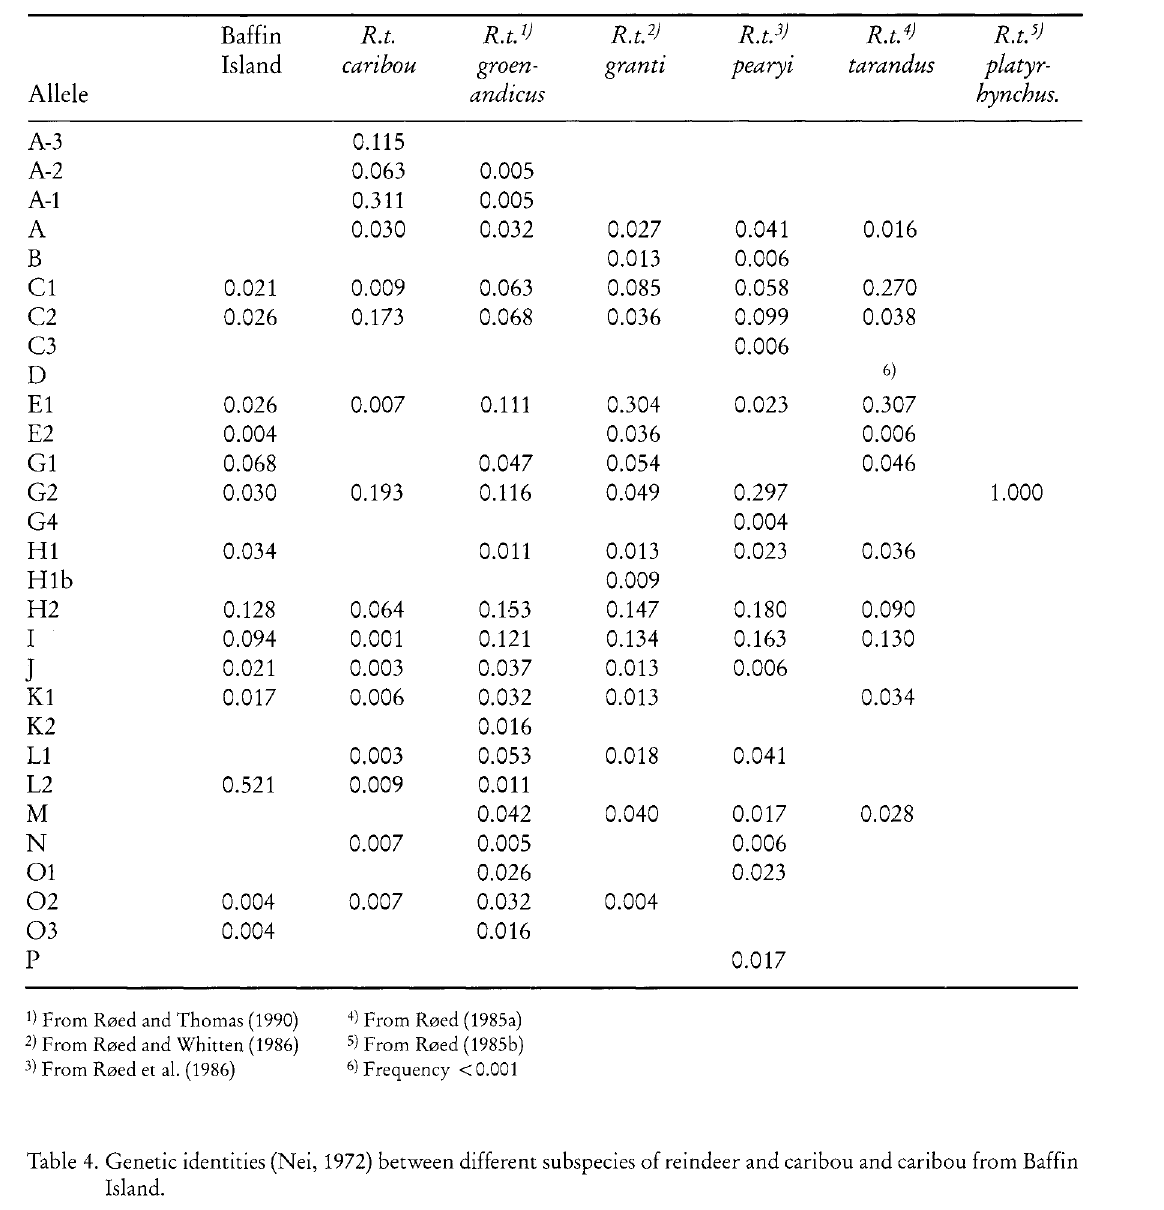
Table 4. Genetic identities (Nei, 1972) between different subspecies of reindeer and caribou and caribou from Baffin